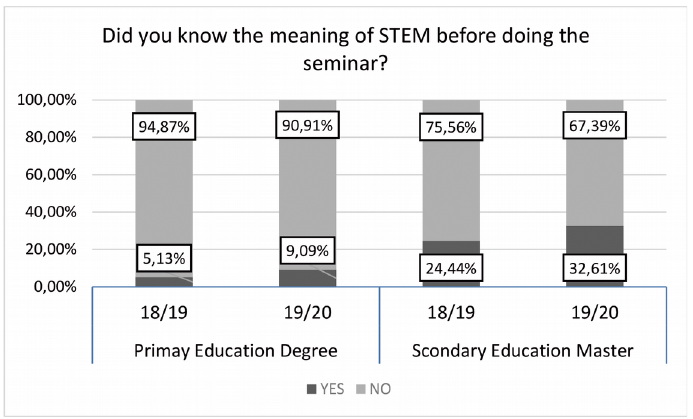
Figure 2. Comparison between prior knowledge about the meaning of the acronym STEM between Primary Education degree students and Secondary Education Master’s